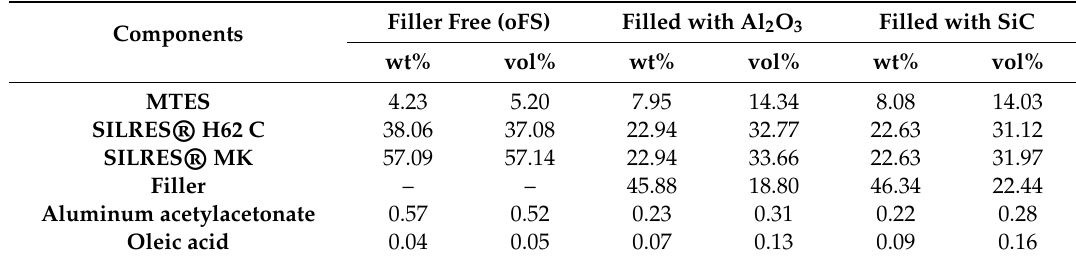
Table 1. Preceramic slurry compositions for the preparation of open porous polymer-derived-ceramics by the replication process with and without fillers. Sample designation oFS means filler-free samples. Filler Free (oFS) Filled with Al 2 O 3 Filled with SiC Components wt% vol% wt% vol% wt% vol% MTES 4.23 5.20 SILRES ® H62 C 38.06 SILRES ® MK 57.09 33.66 31.97 Filler – – 45.88 18.80 46.34 22.44 Aluminum acetylacetonate 0.57 0.52 Oleic acid